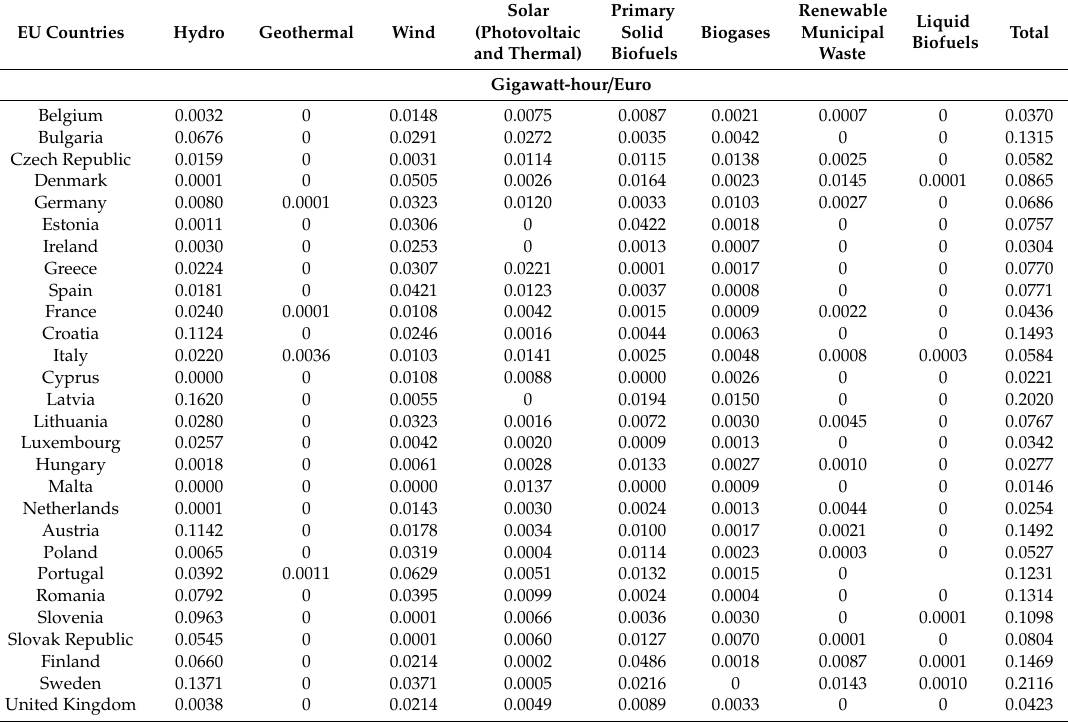
Table 2. Structure of energy production from renewable energy sources in the EU countries in relation to the value of GDP in 2017 (own study based on data from [37]).